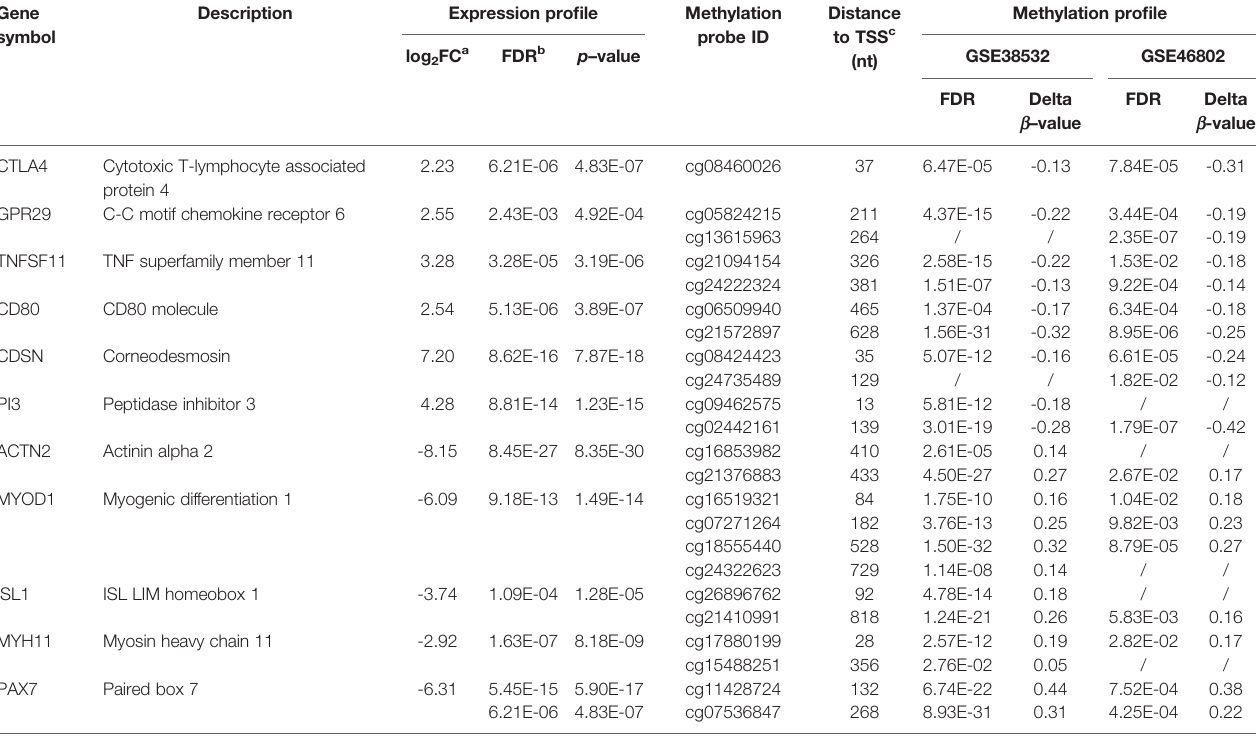
TABLE 4 | Expression and Methylation Pro fi les of Eleven Potential Hub